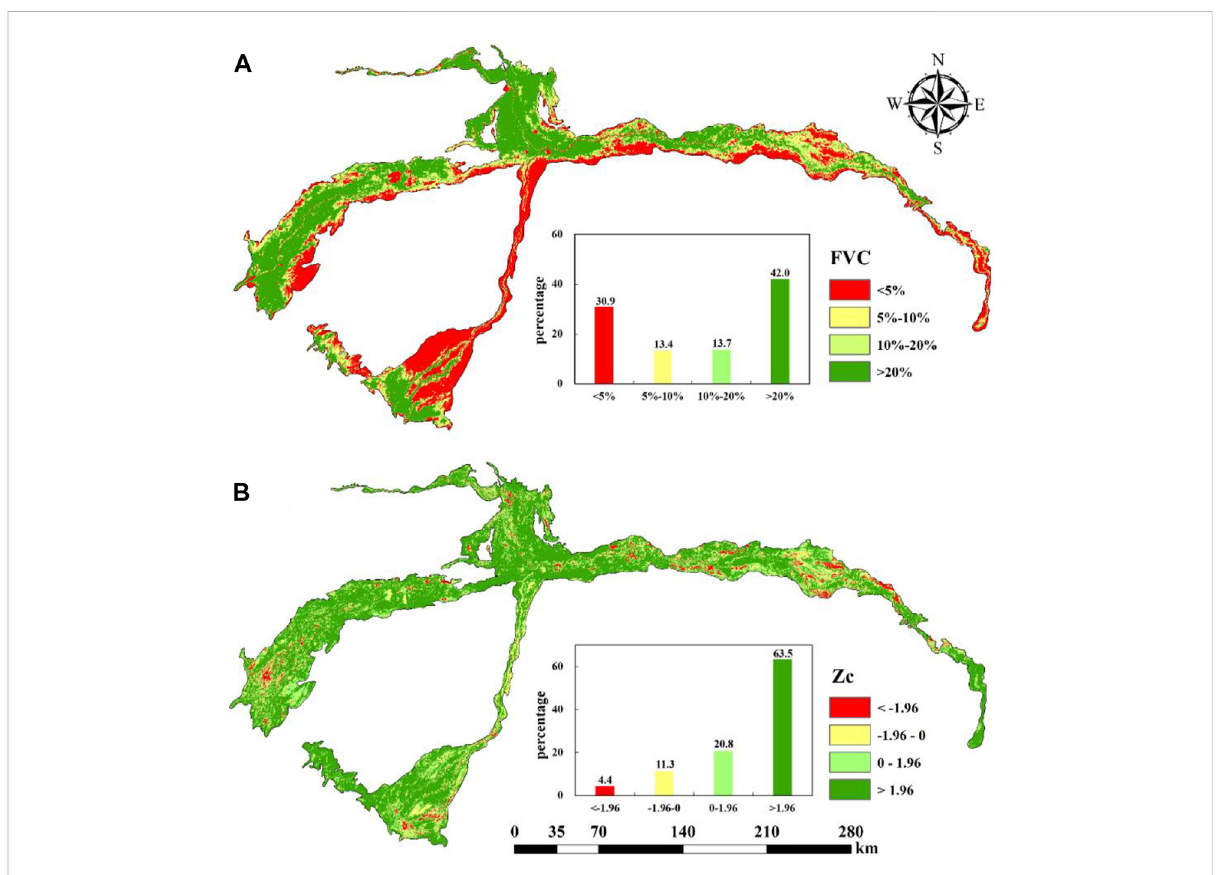
FIGURE 4 Spatial distribution (A) of annual average FVC and spatial distribution (B) of FVC variation trend in Tarim River Basin from 2000 to